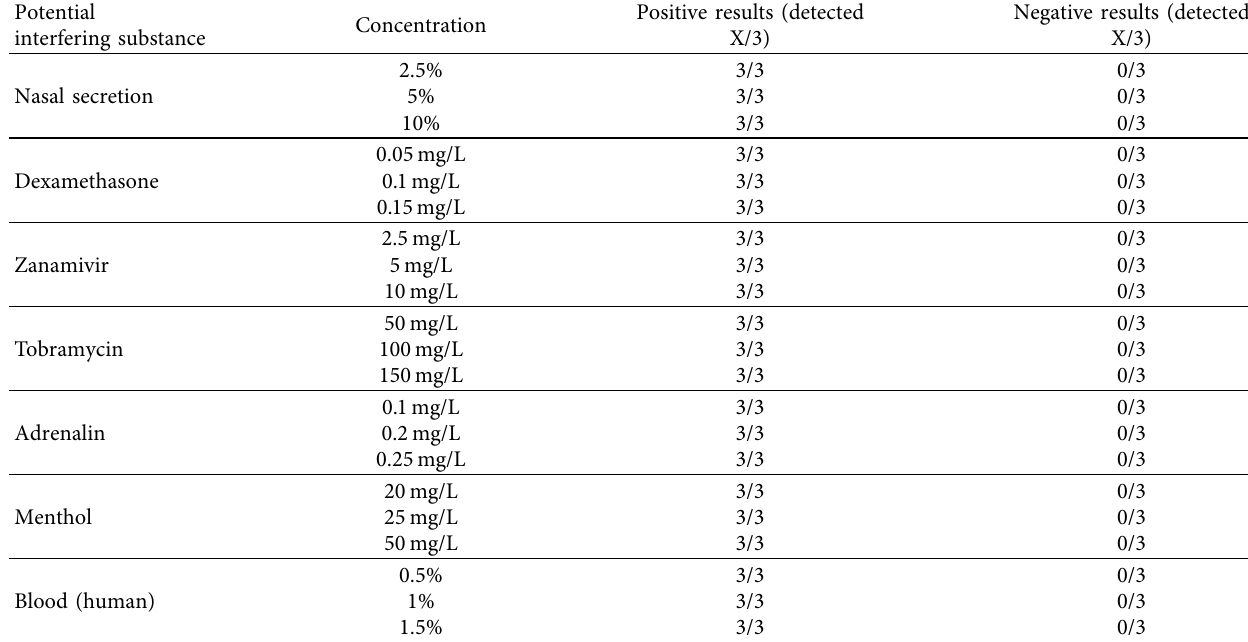
Table 5: Potential interfering testing results.